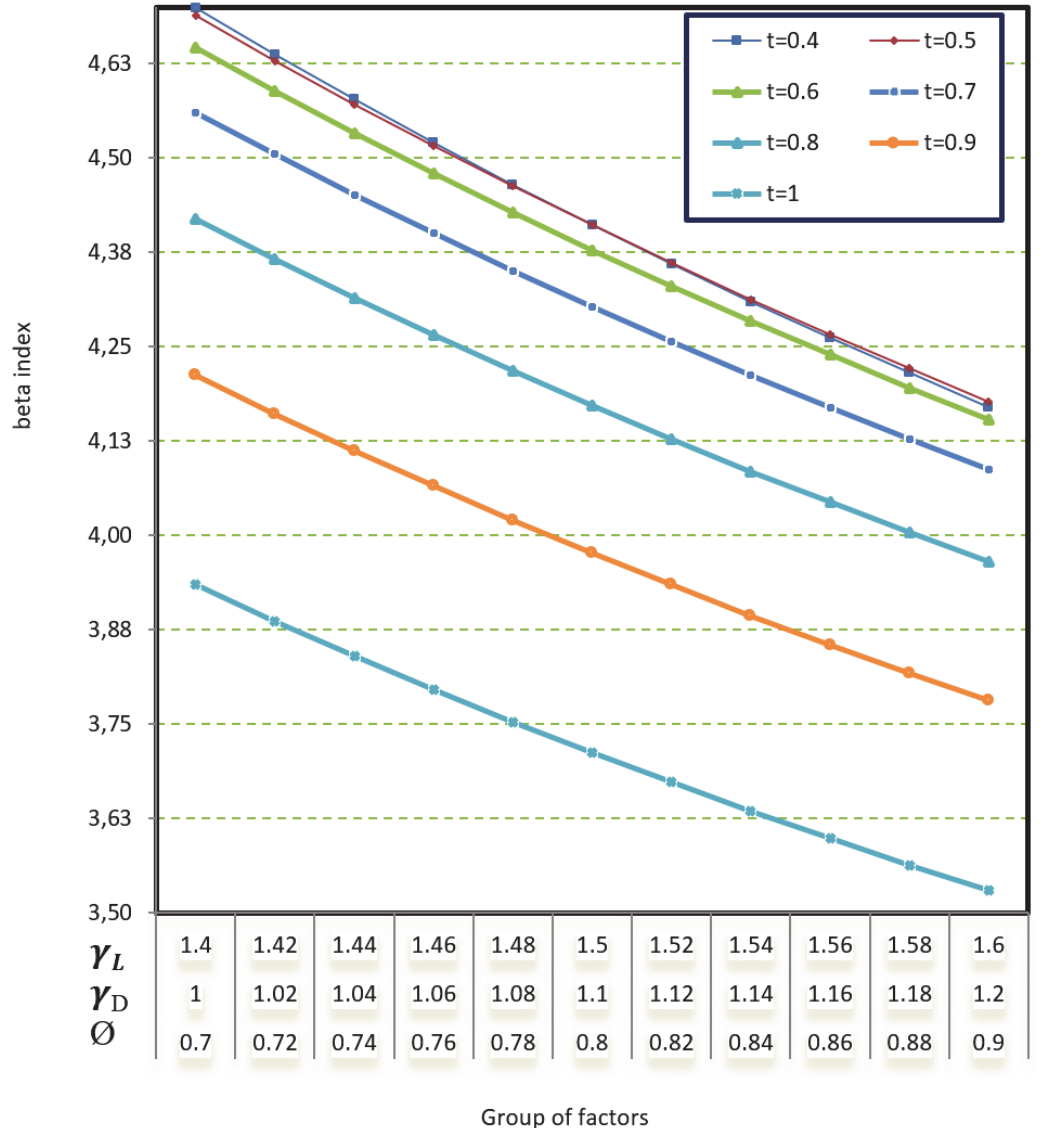
Figure 8: Prediction of load and resistance factors for the rectangular beam in combined